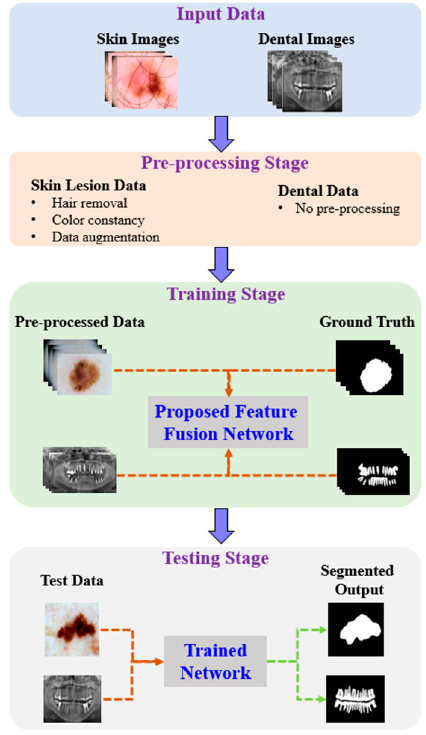
Figure 1. Pipeline of the proposed method.